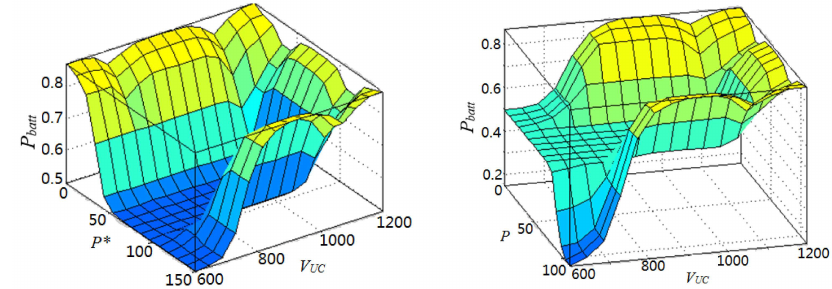
Figure 21. The relationship between the input and output of mode II.